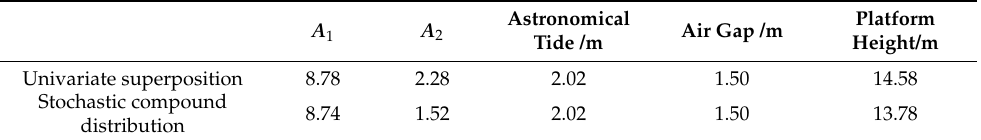
Table 9. Comparison of calculation results of univariate superposition and stochastic compound distribution ( ∆ t = 12 )